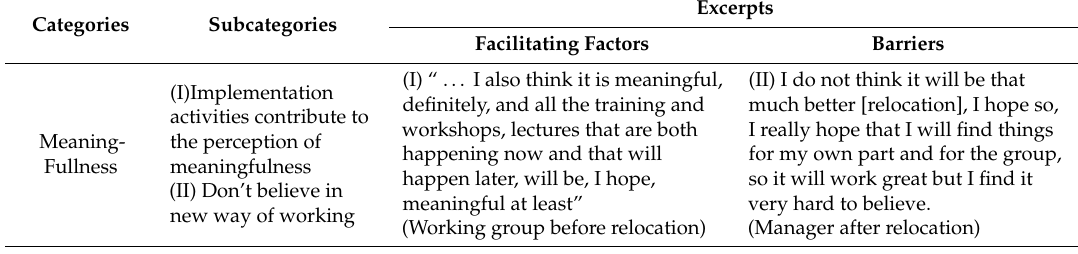
Table 3. Overview of categories and subcategories in the qualitative analysis supported by